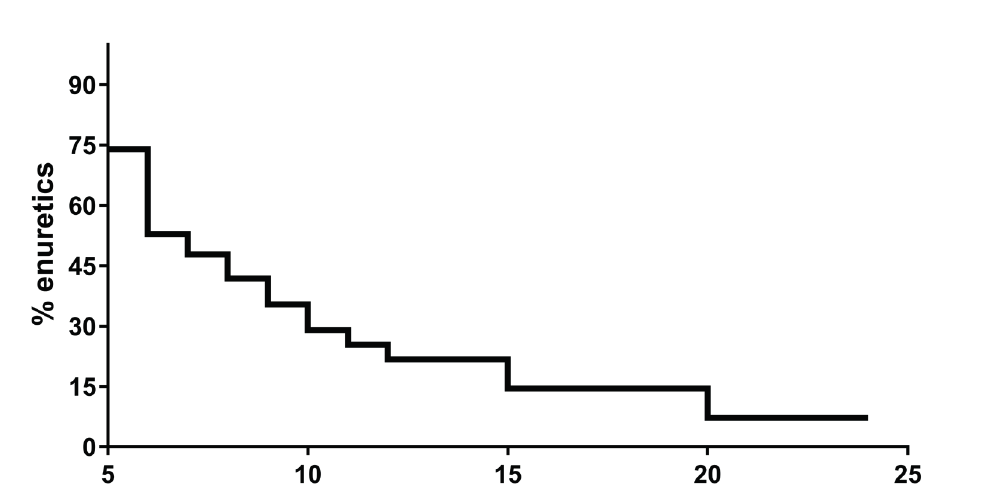
Figure 2 - Prevalence of enuresis according to